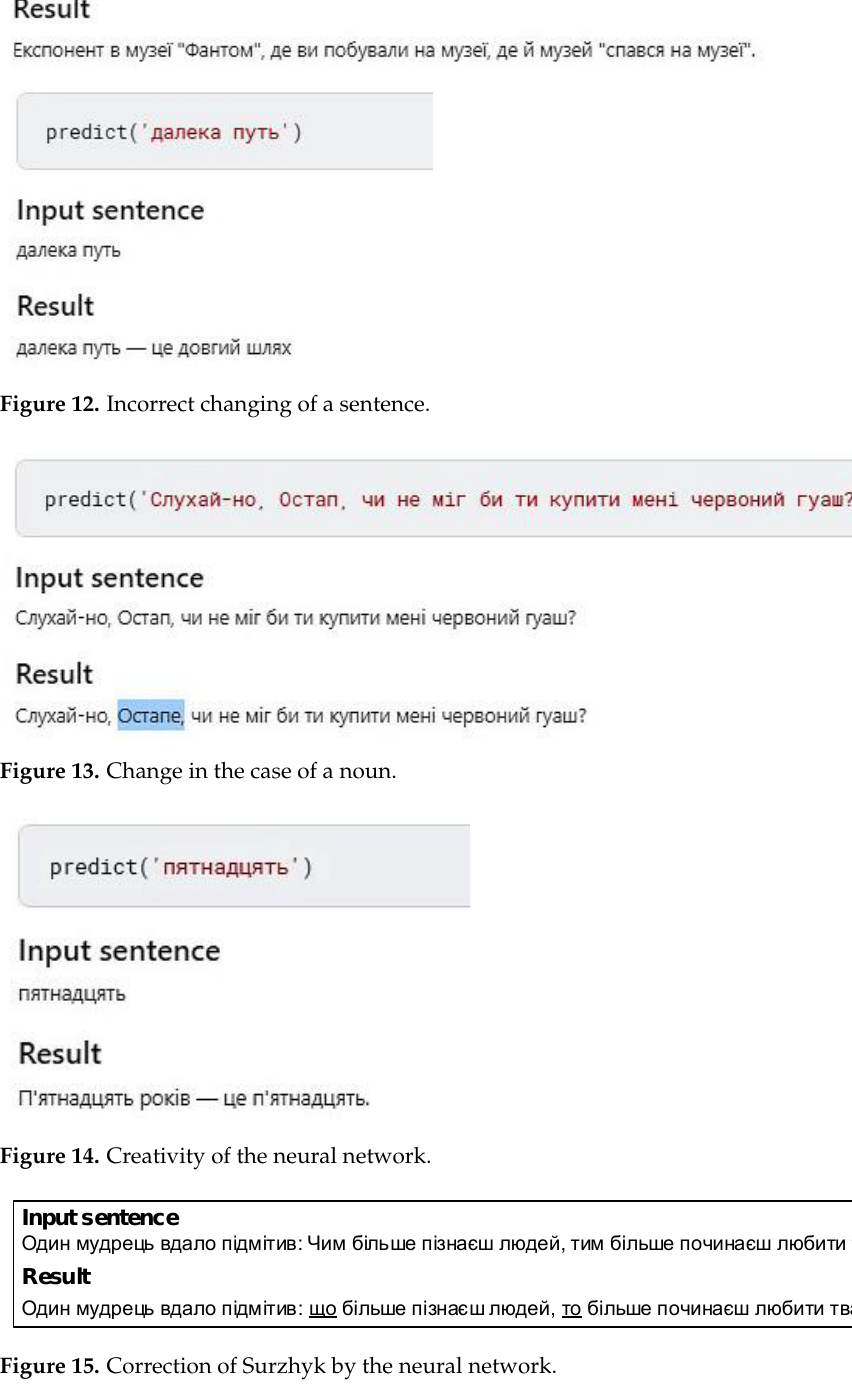
Figure 16. Correction of simple sentences. Figure 17. Wrong correction and variants of correction. In Figure 18a, the neural network correctly replaced the phrase за професії, but the word архітектор is replaced with a word that is closest in meaning. Similarly, the most likely correct answer (number 1 in the list of suggestions) may have an incorrect sentence (Figure 18b), but the correct variant is among the suggestions. In general, correct sentences in the first position, i.e., with the highest probability, occur 51.6% of the time in test sentences. Figure 18. Right correction. In some sentences, mT5 offers more correct corrections (Figure 19). However, for the final assessment and comparison of the neural networks, a sufficiently larger test corpus is required.